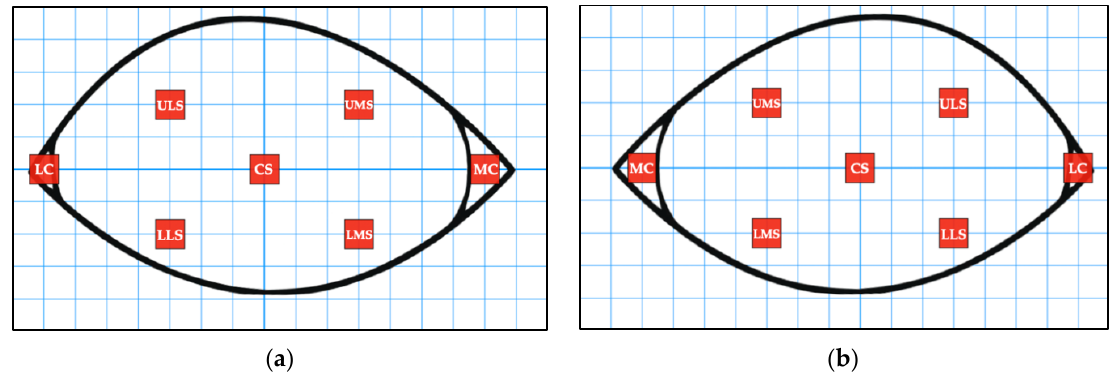
Figure 1. ( a ) The seven locations where the Region of Interest averages were recorded on the right eye. ( b ) The seven locations where the Region of Interest averages were recorded on the left eye.